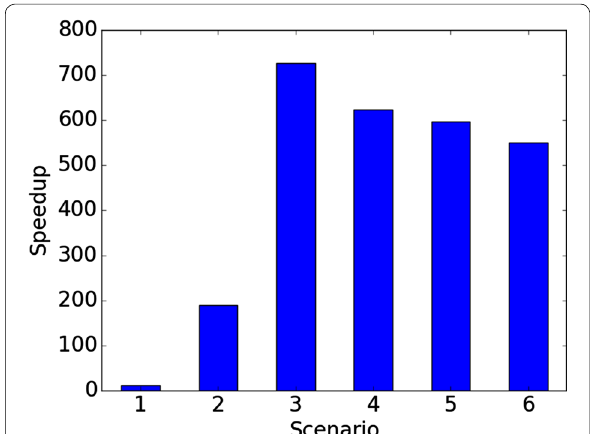
Fig. 5 Relative execution time performance enhancement provided by TNT-NN over LH-NNLS for scenarios 1 through 6. Relative enhancement is reported as speedup, which is the ratio of the LH-NNLS to TNT-NN execution times. The least amount of speedup provided by TNT-NN over LH-NNLS is 10.3. This occurs in scenario 1 where there are no variables requiring